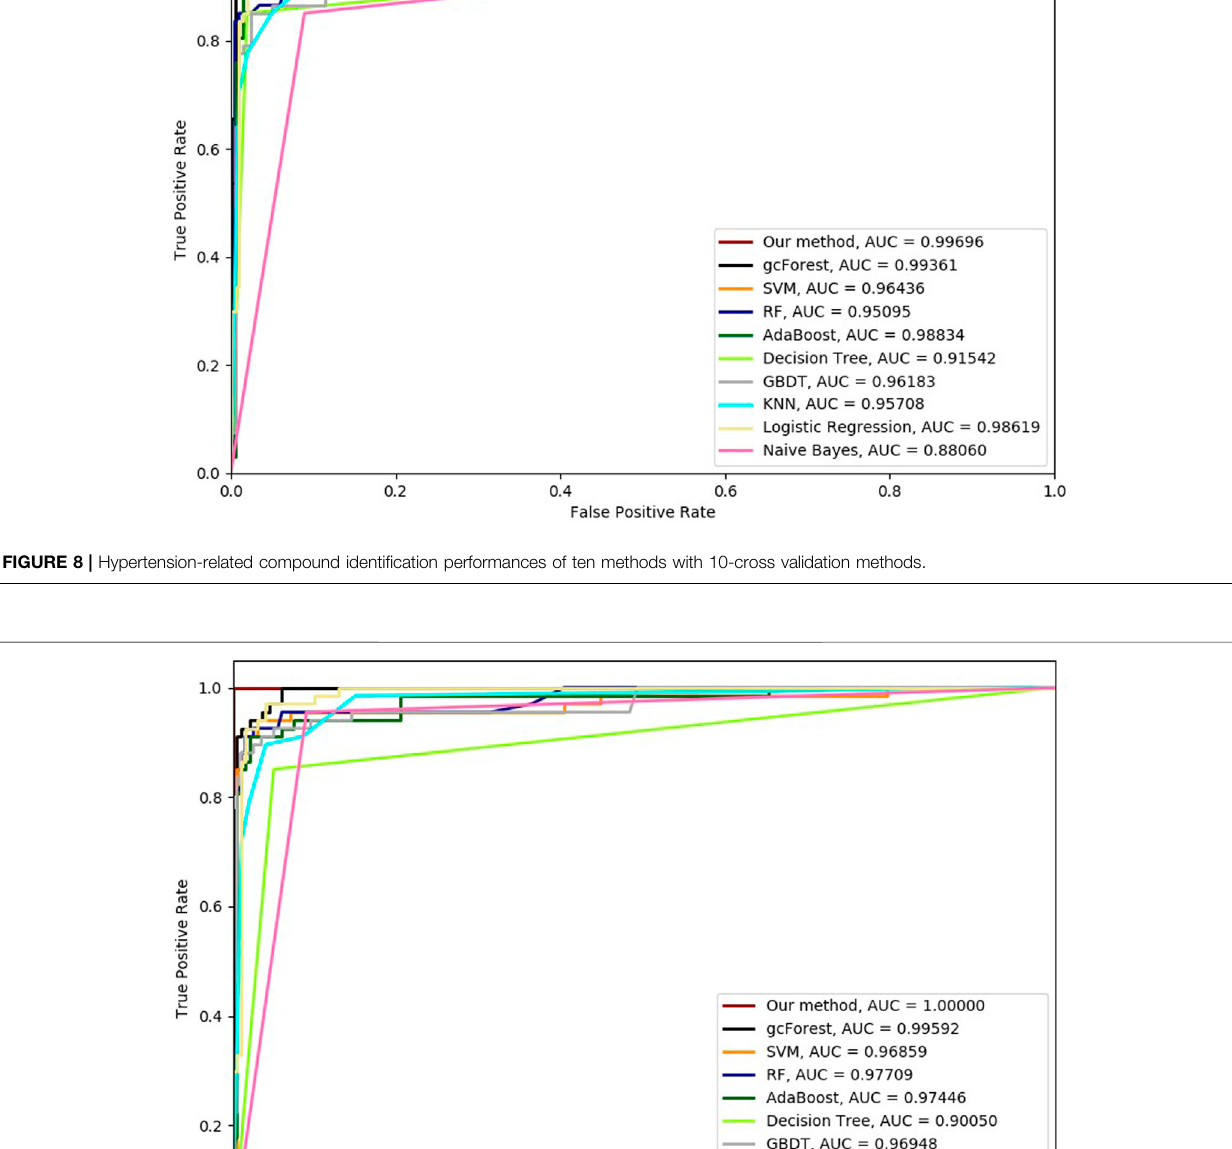
Frontiers in Genetics |